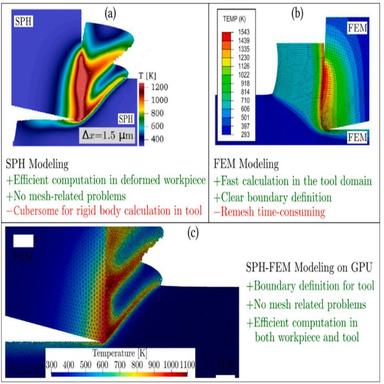
: (a) Illustration of the SPH cutting simulation from the work of Afrasiabi et al. and reconstructed here. (b) An example of the FEM modeling from the work of Arrazola et al., (c) Illustration of the hybrid SPH-FEM metal cutting simulation by Zhang et al..